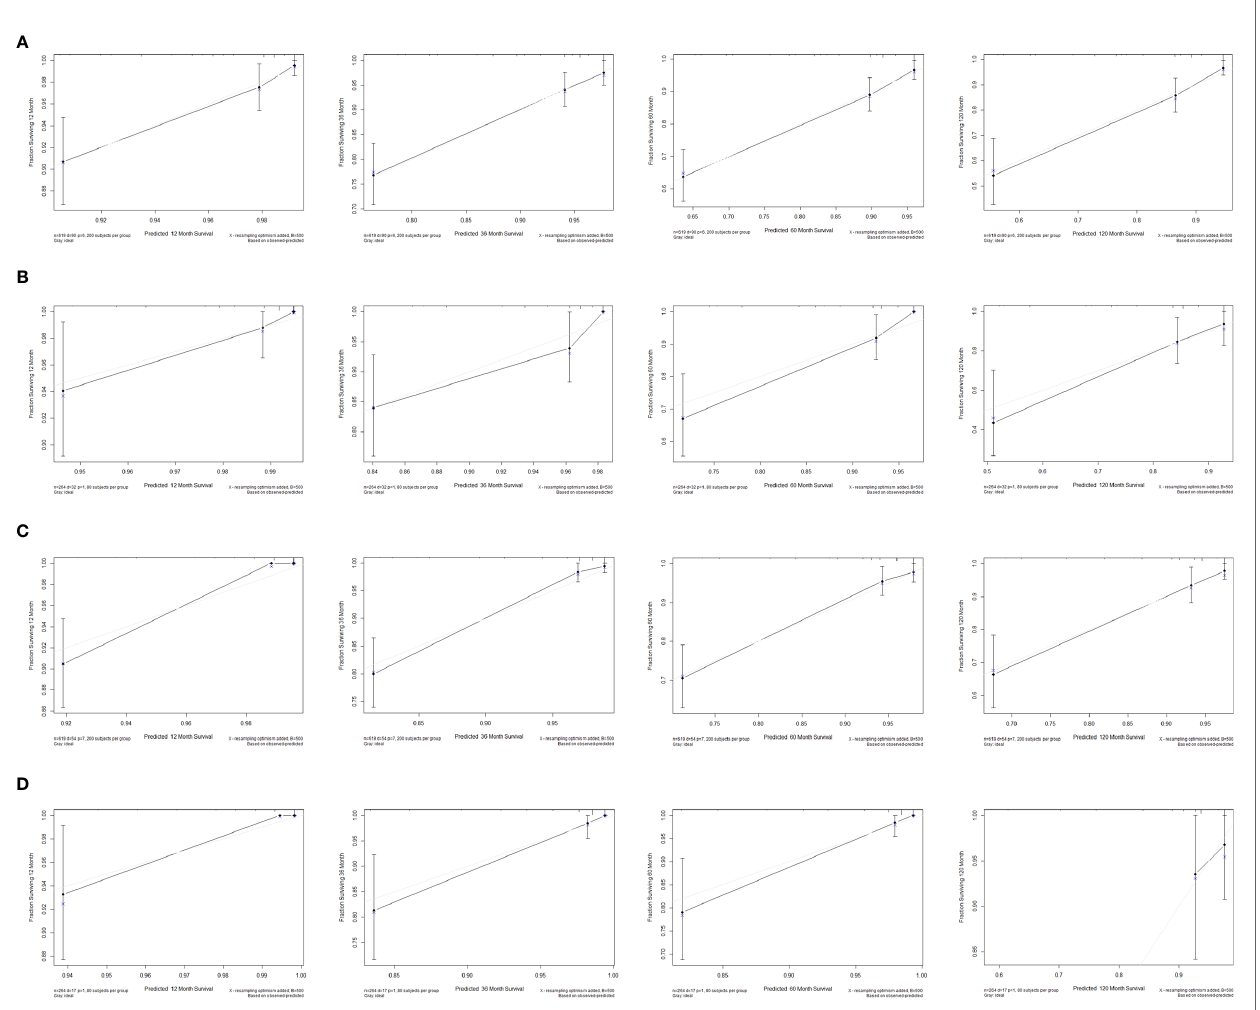
FIGURE 8 | Calibration plots of the nomograms for predicting 1-, 3-, 5-, and 10-year OS and DSS using the training and validation cohort. (A) 1-, 3-, 5-, and 10- year calibration plots of OS using training cohort; (B) 1-, 3-, 5-, and 10-year calibration plots of OS using validation cohort; (C) 1-, 3-, 5-, and 10-year calibration plots of DSS using training cohort; (D) 1-, 3-, 5-, and 10-year calibration plots of DSS using validation cohort. OS, overall survival; DSS, disease-speci fi c survival.